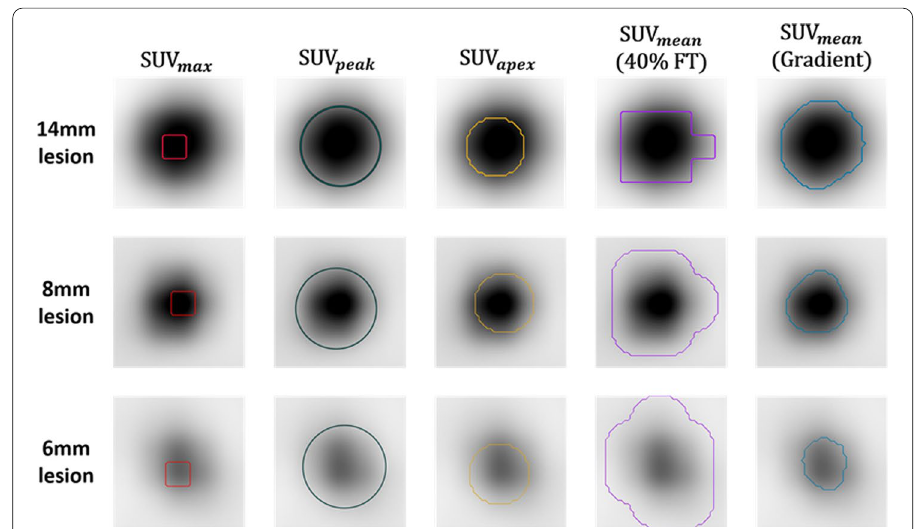
Fig. 5 SUV metrics applied to simulated lesions in the Probe-IQ phantom. Max, peak, apex, 40% FT, and gradient methods applied to PET images of 14-mm, 8-mm, and 6-mm 22 Na epoxy spheres reconstructed with OSEM (32 subsets, two